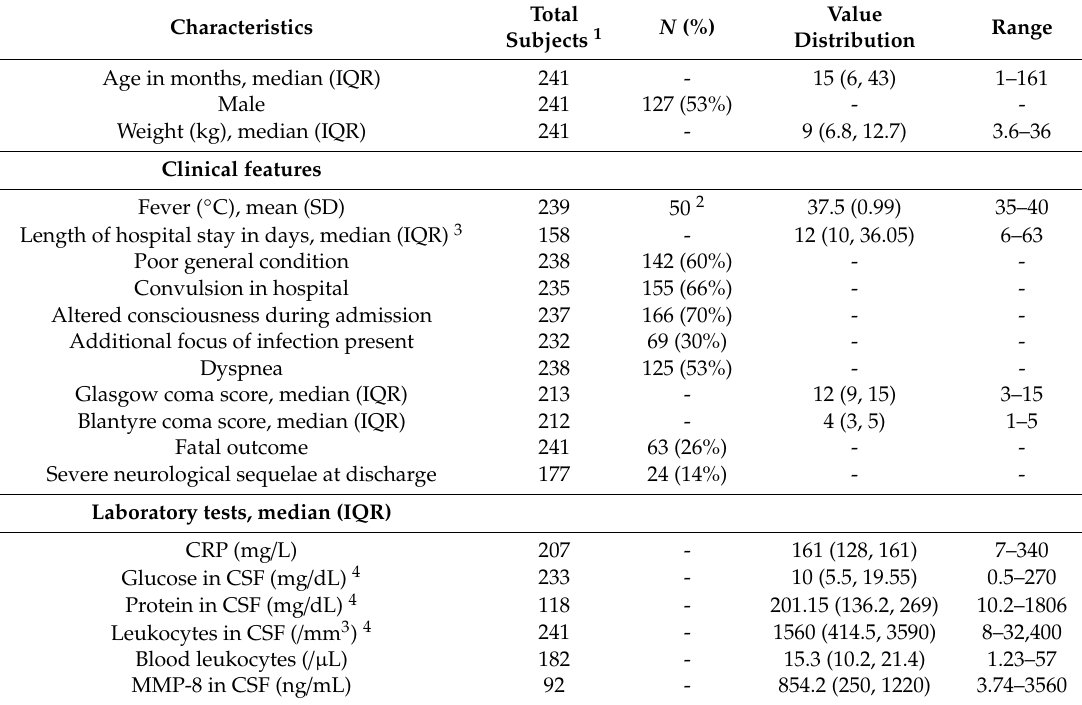
Table 2. Background, clinical, and laboratory data of